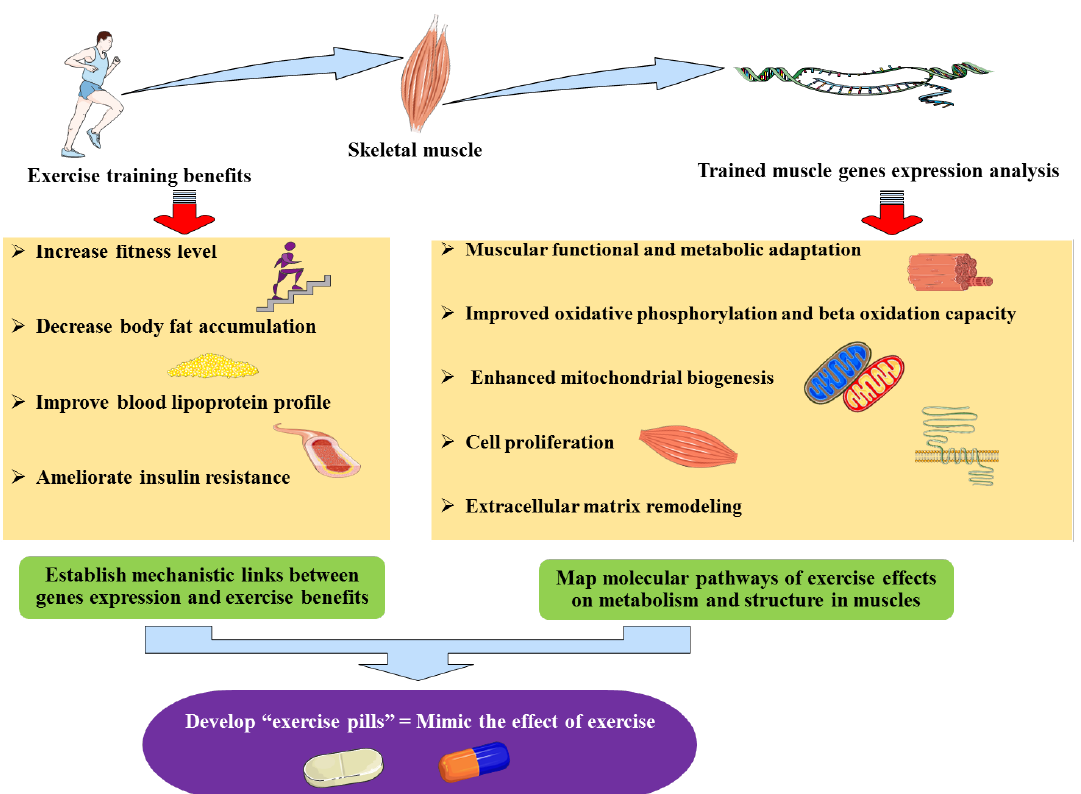
Figure 1. The implications of identifying genes differentially expressed during exercise training: exercise-induced genes.